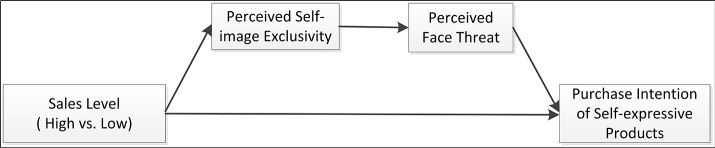
Theoretical model.